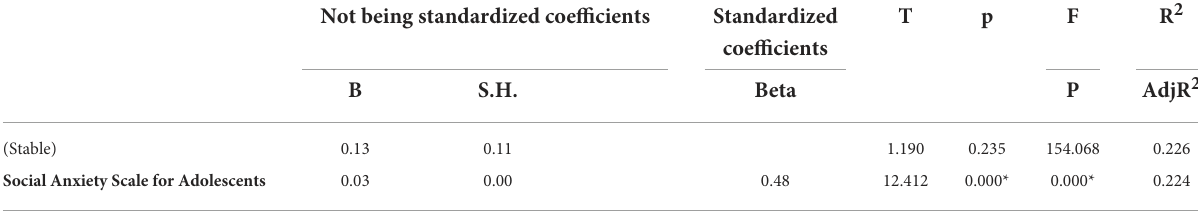
TABLE 5 Prediction of the social anxiety scale for adolescents scores of the students and the scores they got from the Rosenberg Self-Esteem Scale.